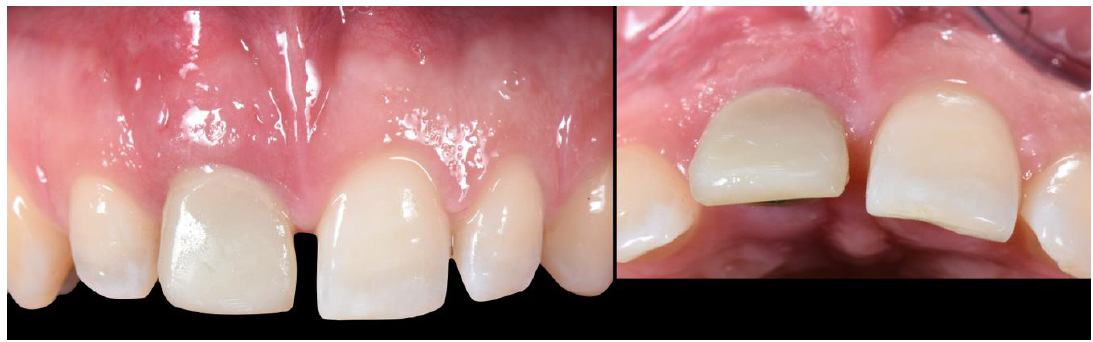
Figure 12. Second re-evaluation at 4 weeks. Clinical image immediately after suture removal.